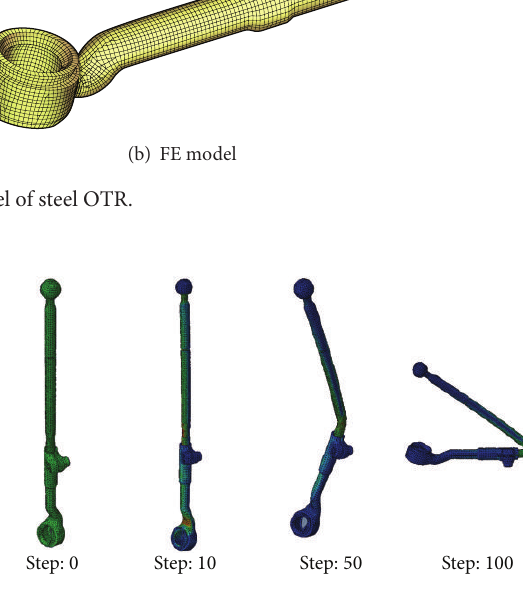
Figure 3: Buckling analysis result of steel